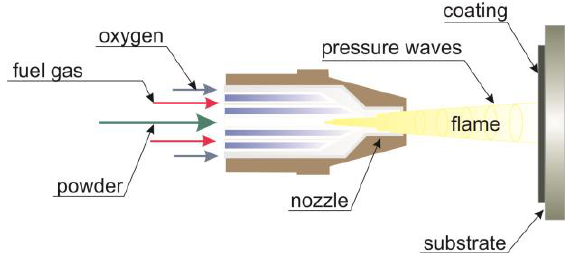
Figure 1. Scheme of the high velocity oxygen fuel (HVOF) spraying process, adapted from [8].